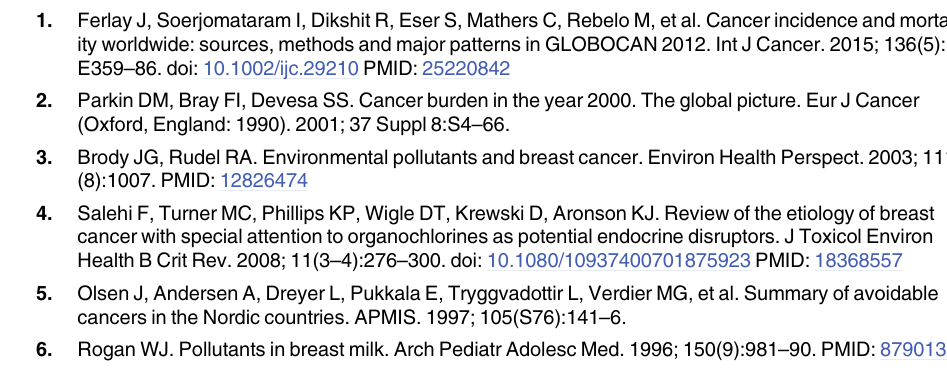
S5 Fig. Forest plot of sensitivity analysis describing the association between total PCB exposure and breast cancer risk excluding three retrospective studies. Apart from the overall analysis, the subgroup analyses on prospective (upper panels) and retrospective (lower panels) studies are presented. S1 Table. Database search strategy. S2 Table. Association between breast cancer risk and PCB congeners grouped according to the classification proposed by Wolff. S3 Table. Association between PCB exposure and breast cancer risk. S4 Table. Evaluation of quality based on the Newcastle-Ottawa scale for the included stud- ies. S5 Table. Characteristics of the excluded studies based on less than 50 breast cancer